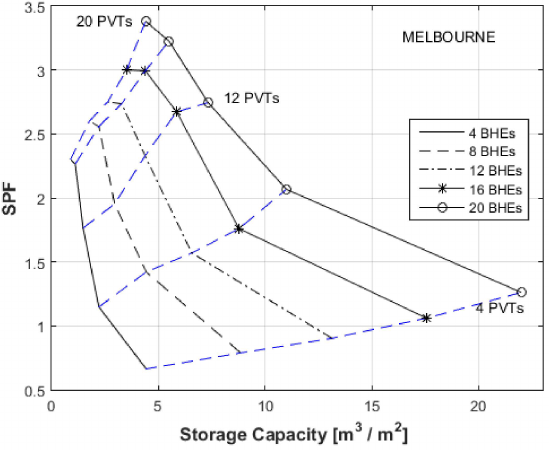
Figure 8. Annual seasonal performance factor as function of the storage capacity for Melbourne.